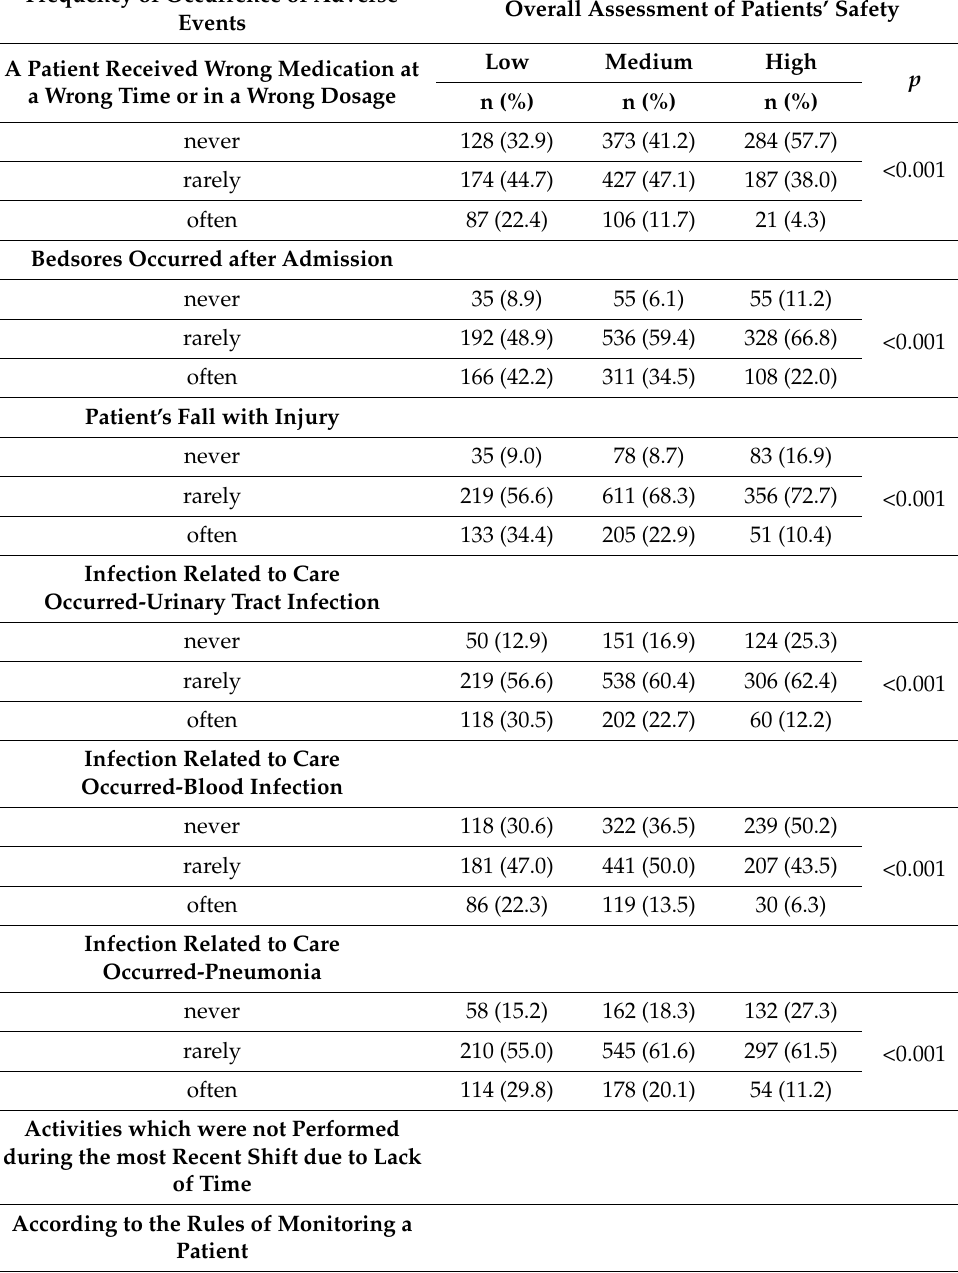
Table 5. Patients’ safety and occurrence of adverse events and unperformed nursing activities. Frequency of Occurrence of